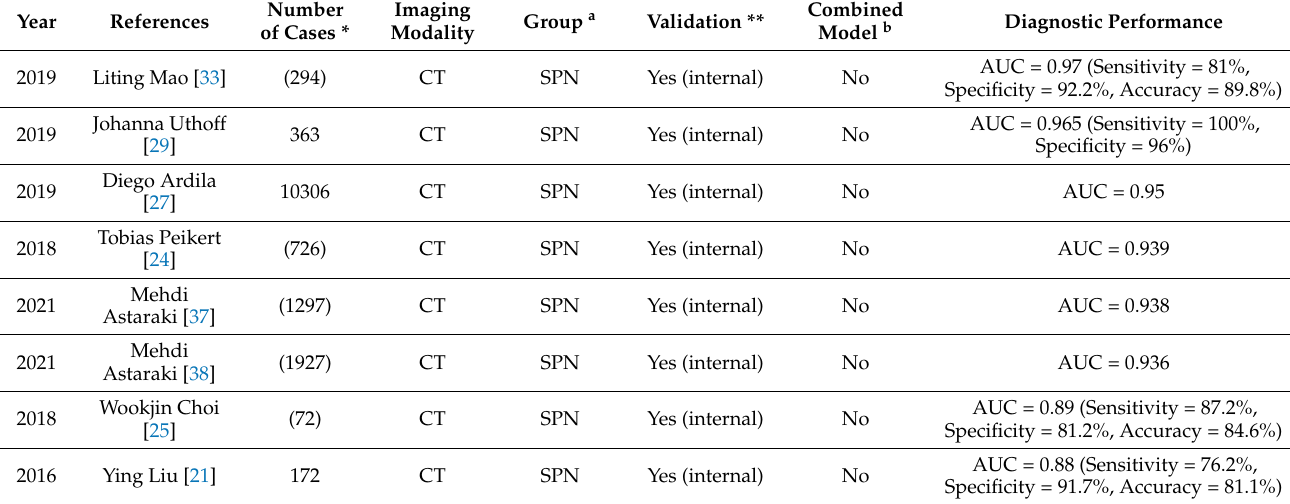
Table 1. Description of studies using different radiomics features to determine the malignancy/benig- nancy of lung